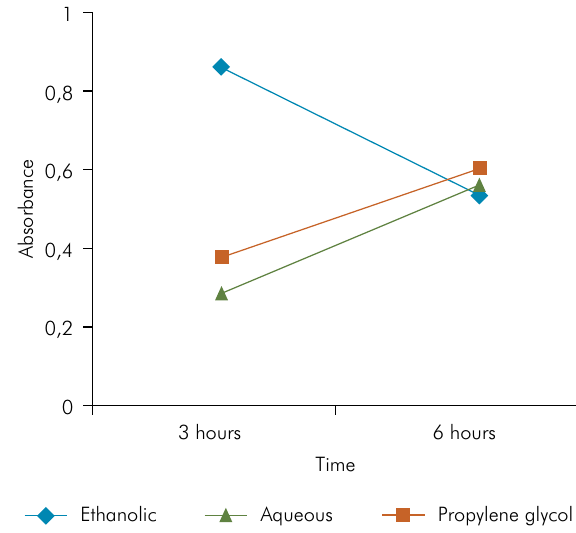
Figure 1. Graphical representation of mean value of edema in both periods